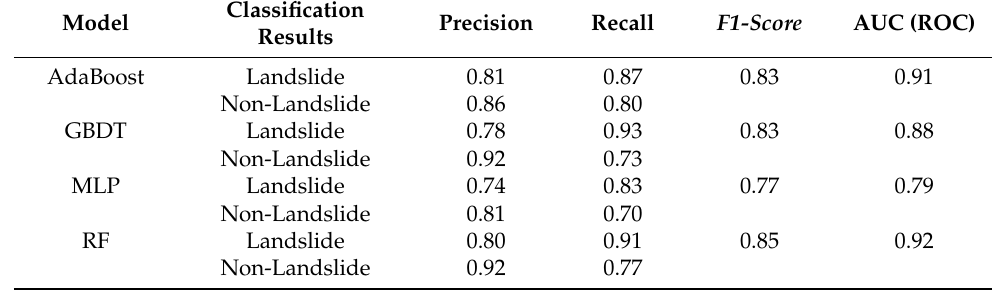
Table 4. Accuracy assessment results for the LR, SVM, MLP, and RF models.